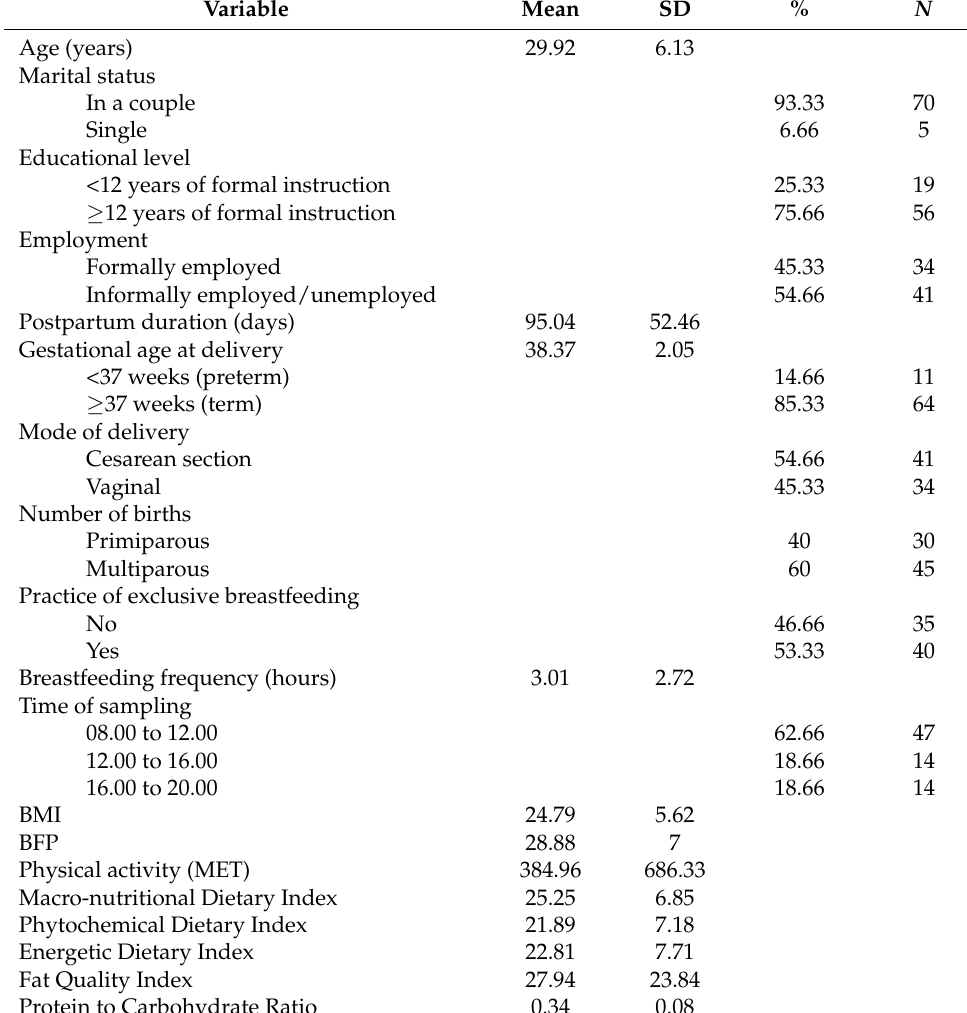
Table 1. Sociodemographic and reproductive characteristics of postpartum women ( n = 75).